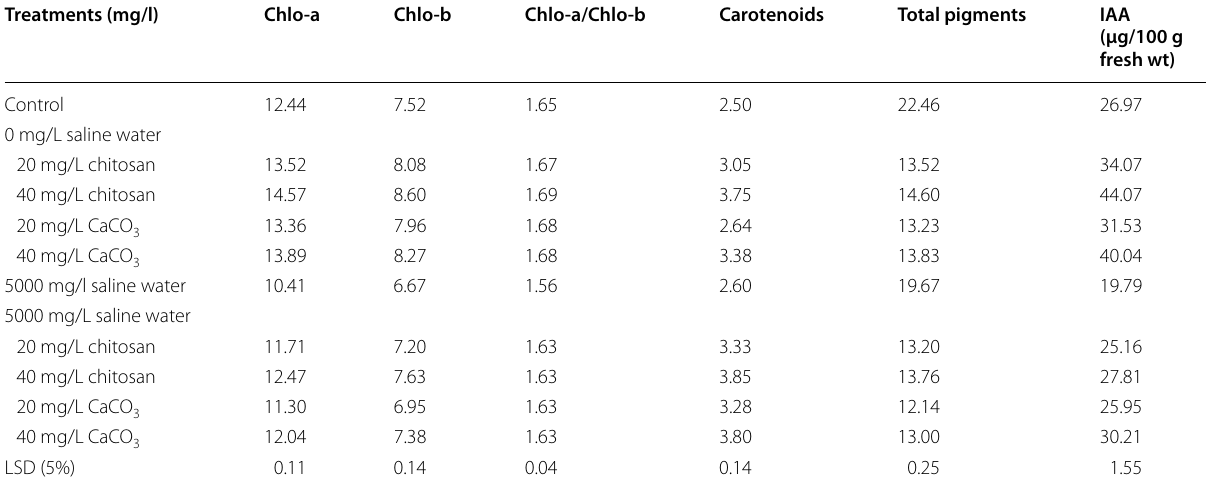
Table 4 Effect of chitosan and calcium carbonate (0, 20 and 40 mg/l) on photosynthetic pigments and IAA (µg/100 g fresh wt) of wheat plant growing under different salinity levels (0, 5000 mg/l) Treatments (mg/l)